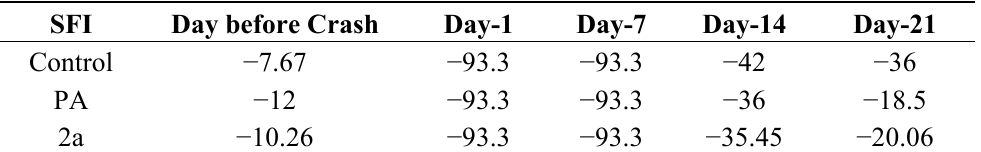
Table 4. Values of Sciatic Functional